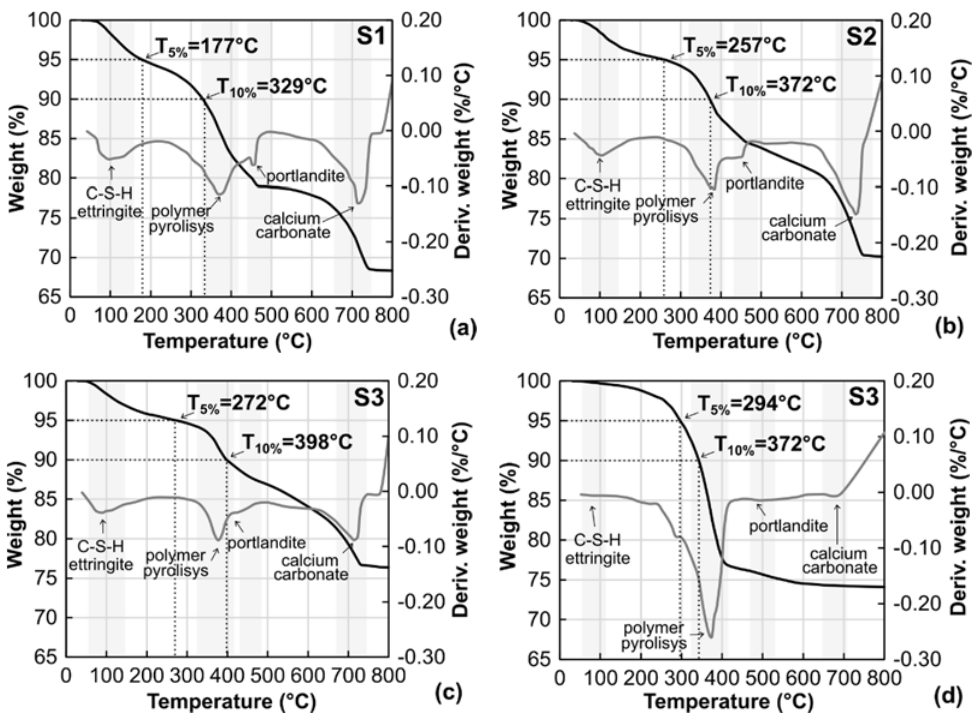
Figure 8. Relationship between remaining mass as a percentage and temperature of samples from ( a ) group S1, ( b ) group S2, ( c ) group S3 and ( d ) group S4.